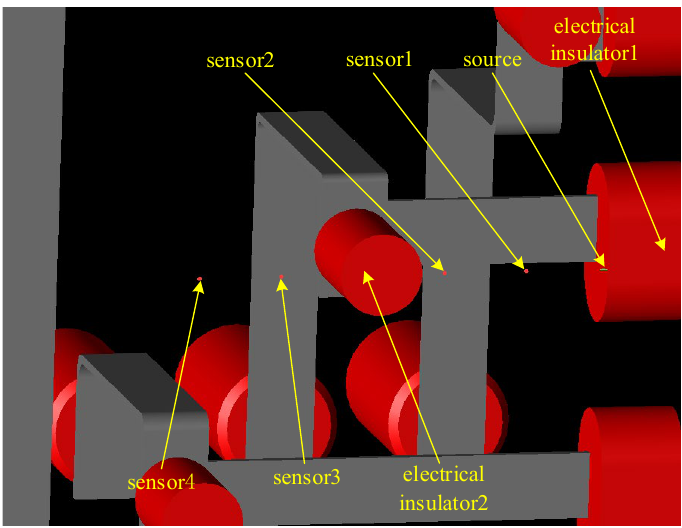
Figure 8. Location distribution of source and point sensors around insulator .